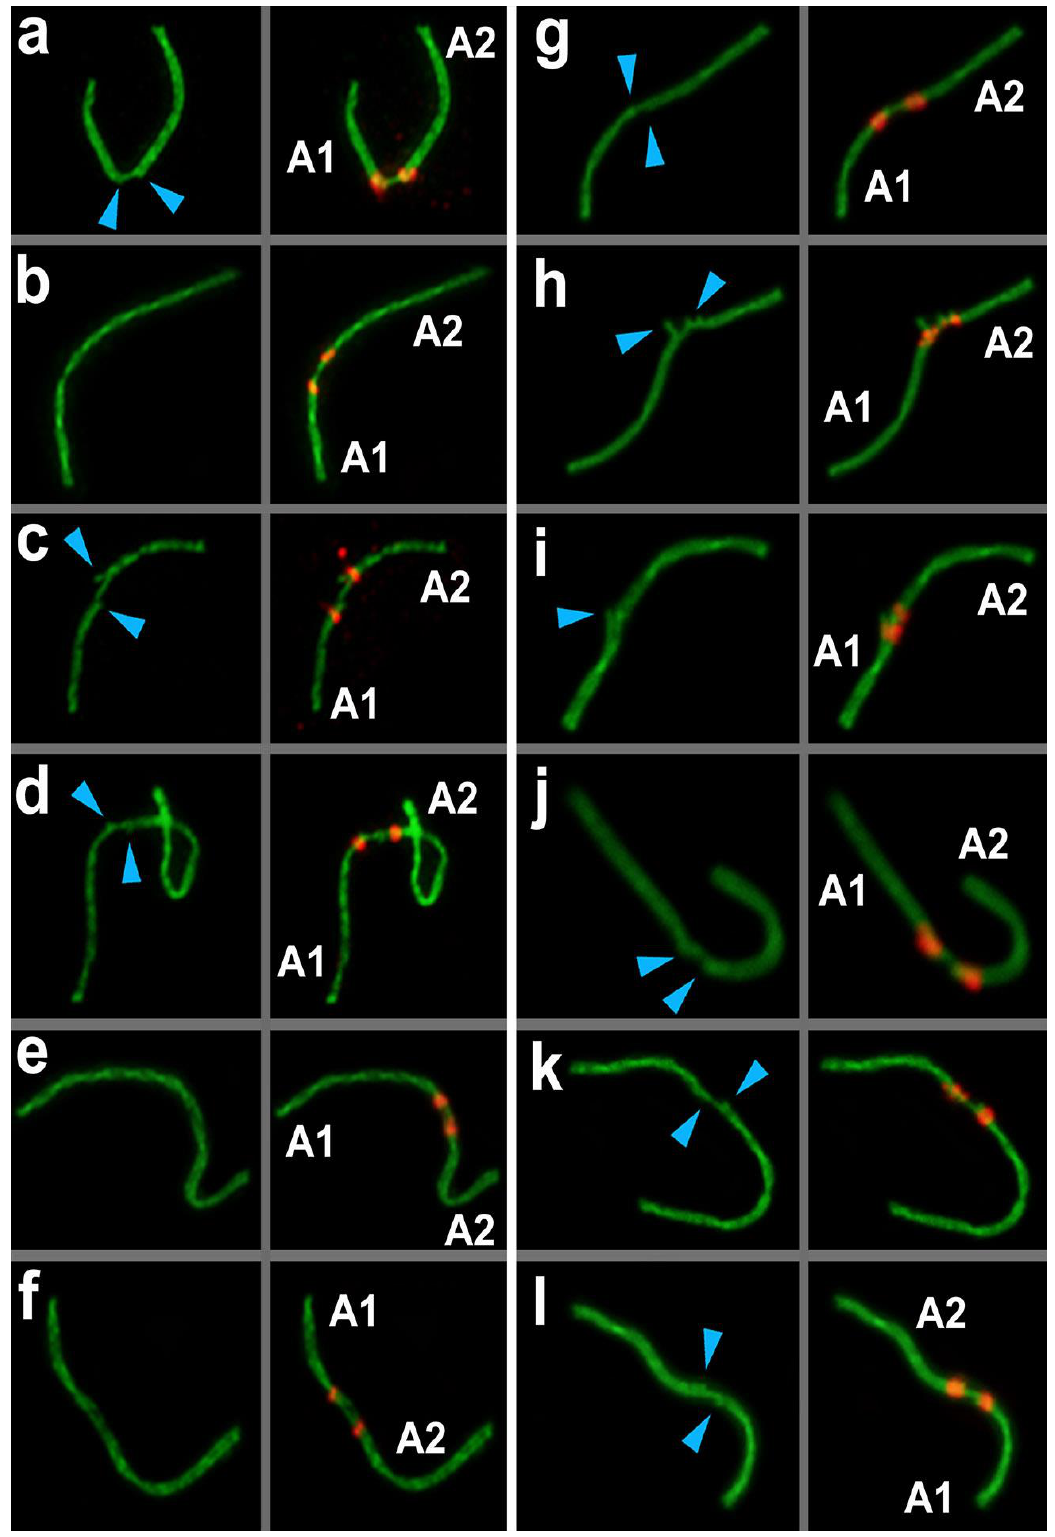
Figure 4. Anchoring/tethering and fusion of non-homologous acrocentric chromosomes in E. alaicus spermatocytes ( a – l ). Lateral elements were identified using anti-SYCP3 antibodies (green), and CREST antibodies for kinetochores (red). A1 and A2—contacting non-homologous acrocentrics. Blue arrowheads show the free ends of lateral elements of non-homologous acrocentrics.